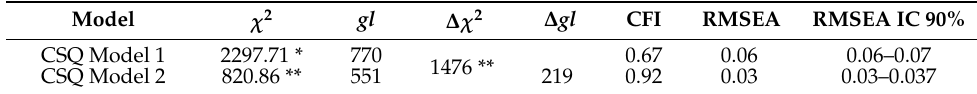
Table 2. Fit indices for second-order factor models for